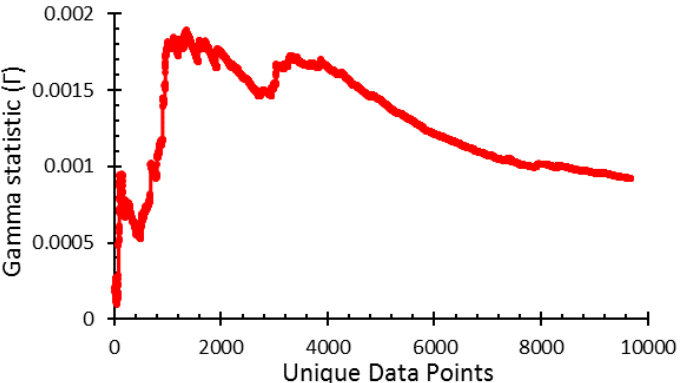
Figure 5. M-test graph for the Magdeburg-Strombrücke gauging station data length.